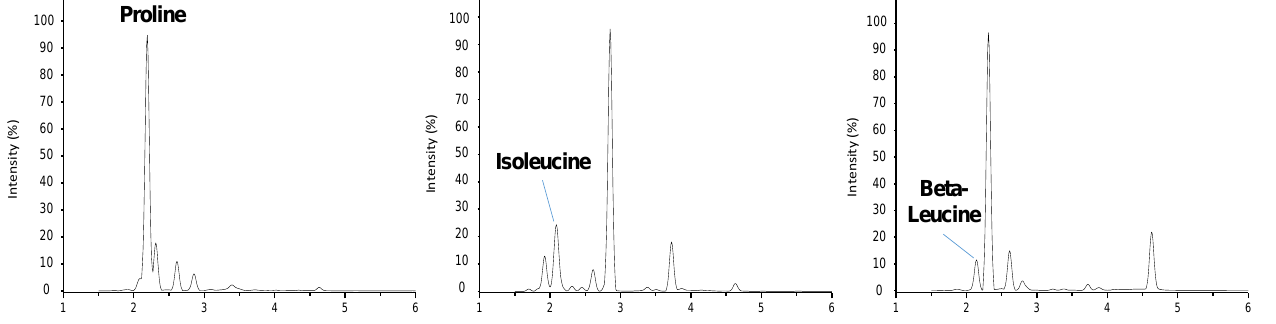
Figure 9. TIC of 31 amino acids derivatized using MCF- MeOH and analyzed using the “short opti- mized” GC -MS program. 1. Alanine, g lycine; 2. β -Alanine, 2-Aminobutyric acid, 3-Aminobutyric acid, 3- Aminoisobutyric acid; 3. Proline, valine, norvaline, isoleucine, allo-isoleucine, leucine, thre- onine, β -Leucine, homoserine; 4. Aspartic acid; 5. Methionine; 6. Phenylalanine; 7. Lysine; 8. Histi- dine; 9. Tyrosine. Similarly to MTBSTFA, fragmentograms can be used to differentiate between multiple coeluted compounds (Figure 10) with a unique mass fragmentation for each derivative (Figure 11).